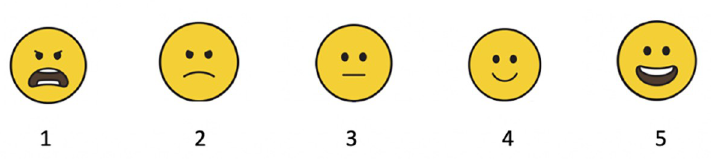
Fig 3. Evaluation emoji rating scale with 1 coded as most negative/distressed and 5 coded as most positive/happy.